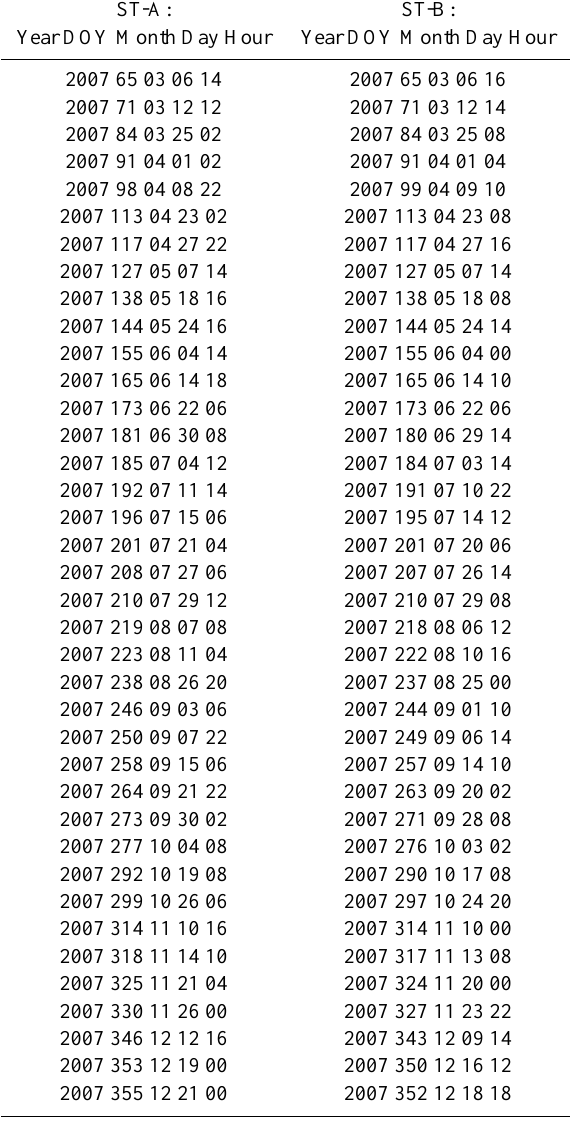
Table 2. List of stream interfaces associated with CIRs at each of the two STEREO spacecraft during the period 1 March–31 Decem- ber 2007. See Fig. 2 and text for SI definition.